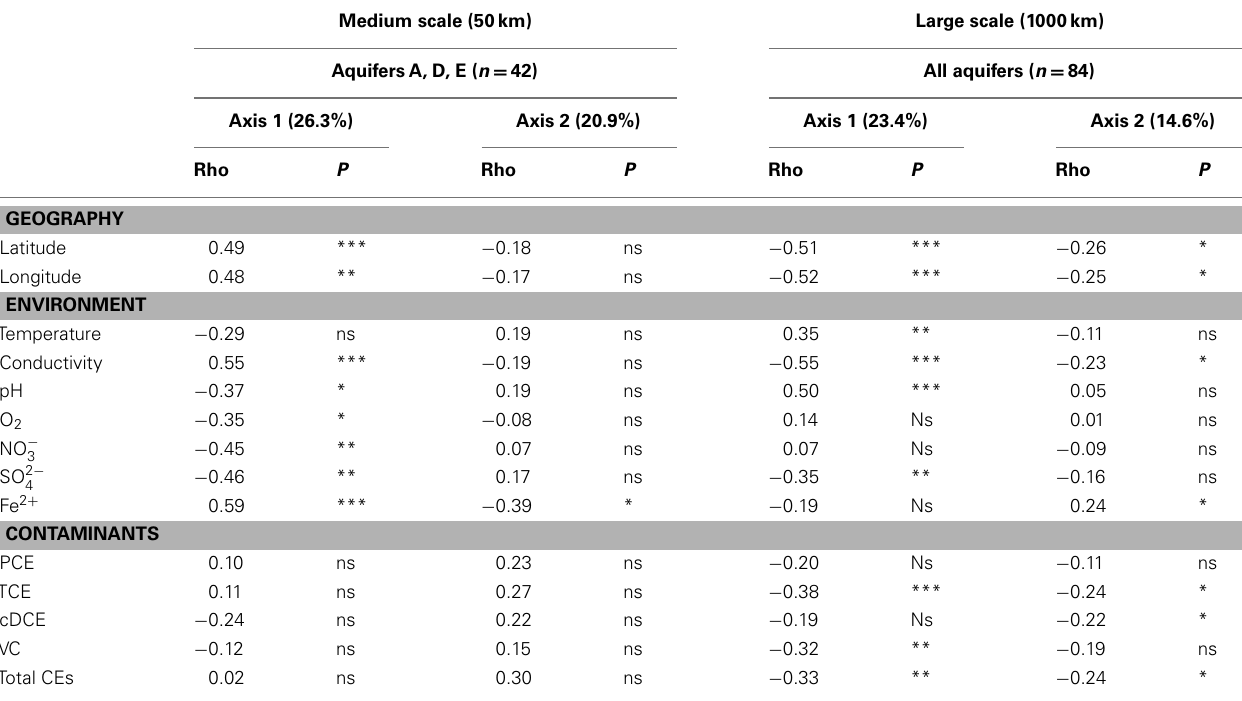
Table 2 | Pearson correlation coefficient calculated between environmental variables and sets of sample coordinates on the first two axes of the FPCA, corrected for “ Methodology